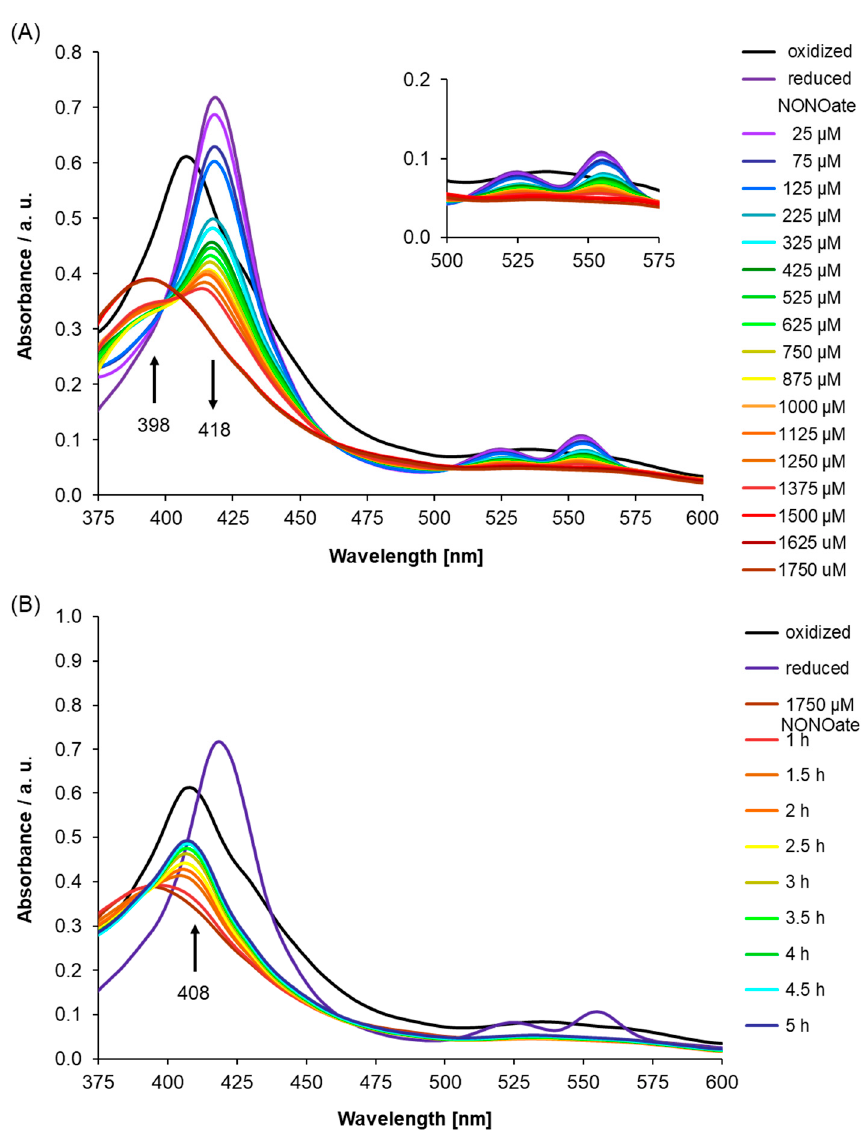
Figure 4. ( A ) Nitric oxide (NO) binding to an Light Response Bric-a-Brac/Tramtrack/Broad Complex (AtLRB3)/H357L mutant was monitored after the addition of diethylamine/nitric oxide complex (DEA NONOate) (NO donor) to reduced mutant AtLRB3 (400 µg/mL) under anaerobic conditions. After purification, air-oxidized protein shows a Soret peak at 408 nm, which shifts upon chemical reduction by sodium dithionate (8 mM) to 418 nm with the appearance of β - and α -peaks (525 and 553 nm). Addition of the NO donor leads to the formation of NO-bound protein showing a broad shoulder at 398 nm. NO affinity of the H357L mutant is reduced compared to the wild-type (see Figure 3). (black: oxidized, dark violet: reduced, violet–brown: NO addition in increments) Inset: Highlights α - and β -peak regions. ( B ) As for the wild-type protein, the behavior post-NO-saturation (pNs) was monitored for the AtLRB3/H357L mutant under anaerobic conditions. Absorption spectra were measured at several time points. Over time, this results in a reappearance of the Soret peak of oxidized heme iron at 408 nm. Compared to wild-type protein, diffusion occurs much faster. UV/Vis spectra of the ferric and ferrous protein are included for comparison (black: oxidized, dark violet: reduced, brown: NO-saturated protein, red–blue: pNs spectra measured at several time points).